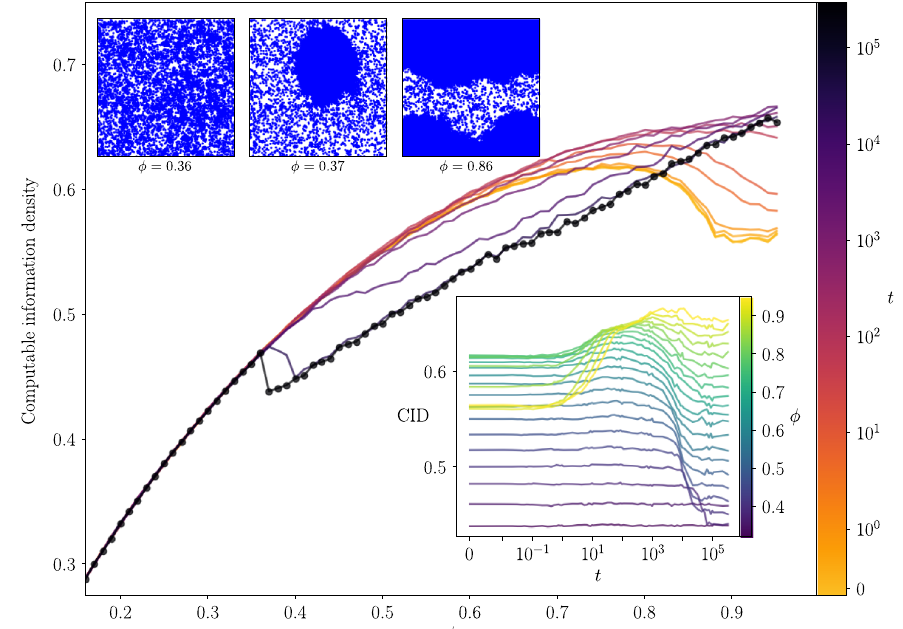
FIG. 5. Active Brownian particles: Systems of 16 384 × ρ disks with short-range repulsion, self-propelling at speed v 0 ¼ 0 . 1 . Coordinates are quantized (digitized) using a square grid with bin-size approximately d= indicating ordering associated with clustering and motility-induced phase separation [56]. Representative configurations are shown for ϕ ¼ 0 . 37 , 0.39, 0.86. For the initial quenched configurations (yellow curve) the flat region for ϕ ⪆ 0 . 88 corresponds to samples consisting of small grain crystals. The inset shows the time dependence of the CID for different